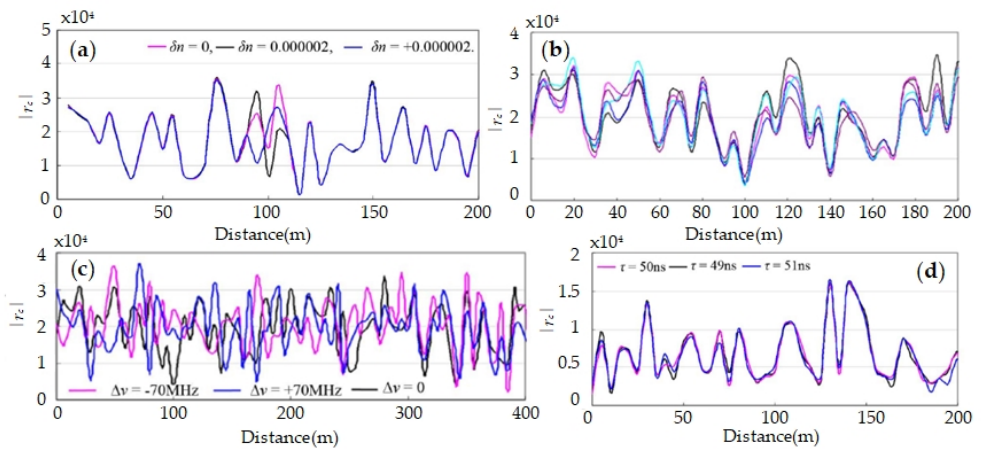
Figure 4. Fading patterns with various ( a ) local refractive index changes, ( b ) standard deviations of Rayleigh coefficient, ( c ) laser frequency, and ( d ) pulse width. Reproduced from our previous paper [58].